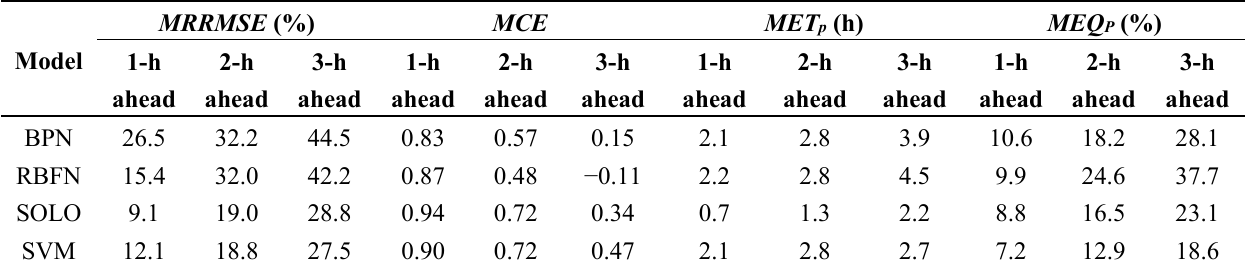
Table 2. Results of four NN-based flow forecasting